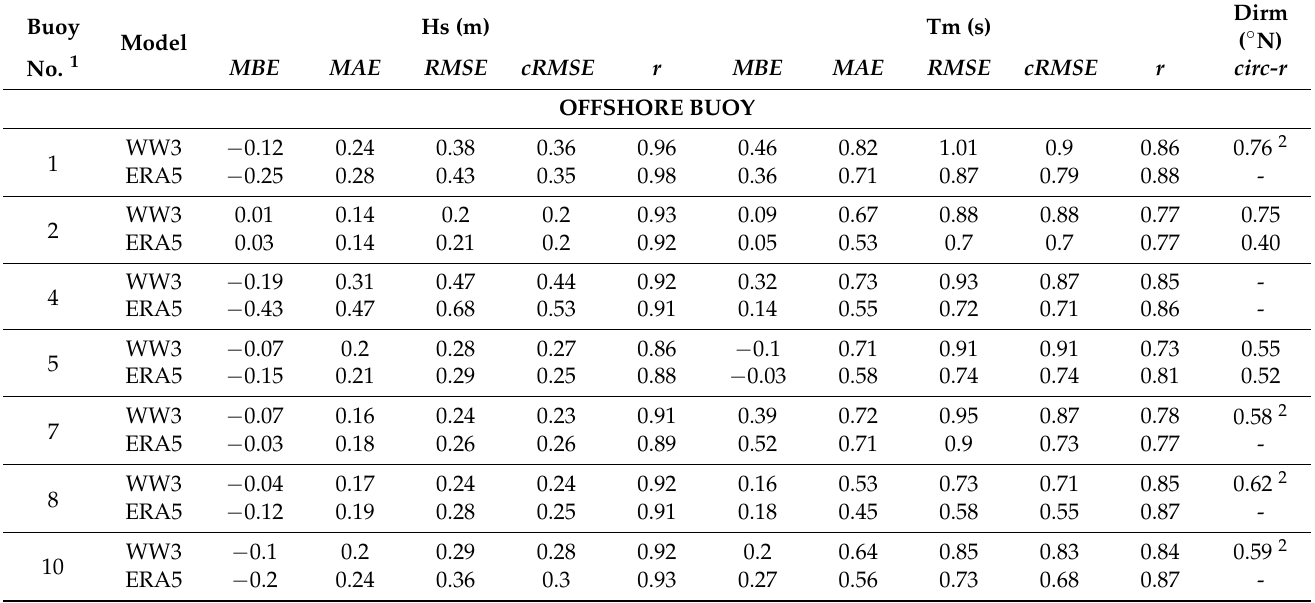
Table 10. Statistical indicators for Hs, Tm and Dirm (or Dirp) evaluated for the offshore and coastal buoys in Table 3. In this table, the WW3 model represents the wave hindcast results and the relative ERA5 dataset. Buoy